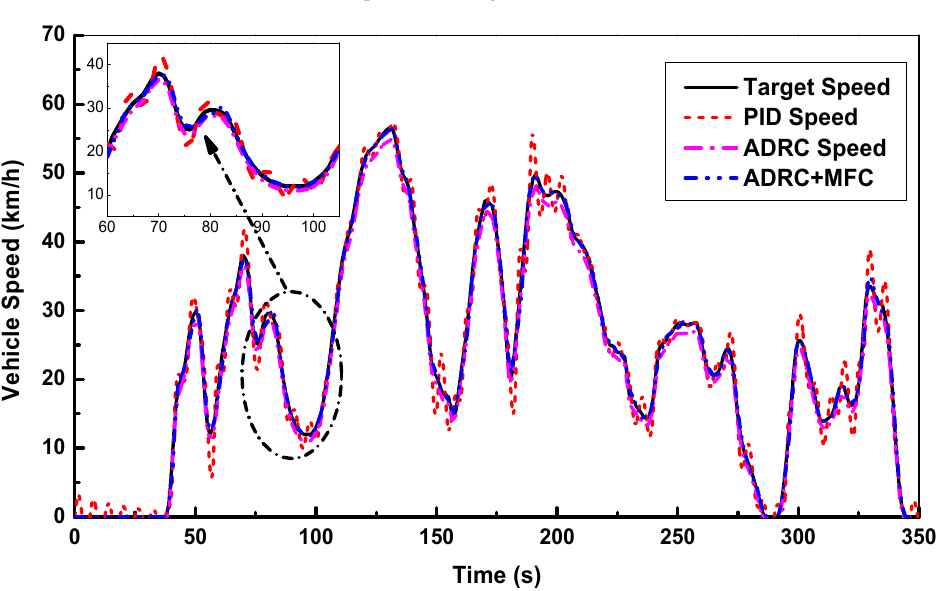
Figure 5. Speed tracking results for Case 1. Table 3. Tracking error statics with vehicle mass 1800 kg and incline 0°.